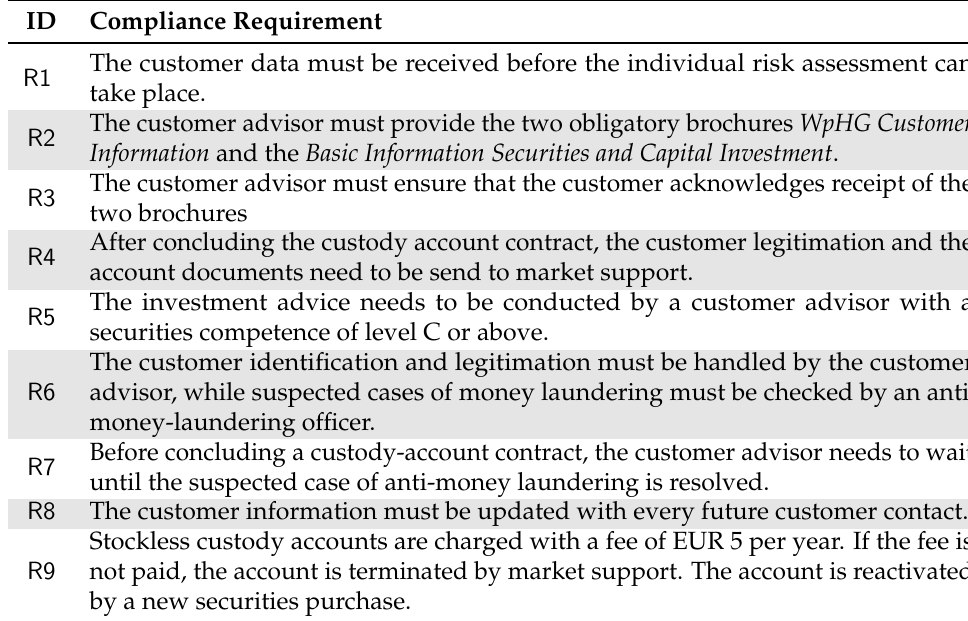
Table 3. Compliance requirements of the securities purchase